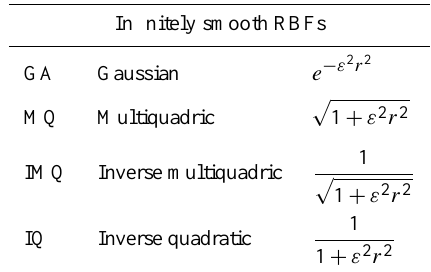
Table 1. Some commonly used infinitely smooth radial functions φ(εr)